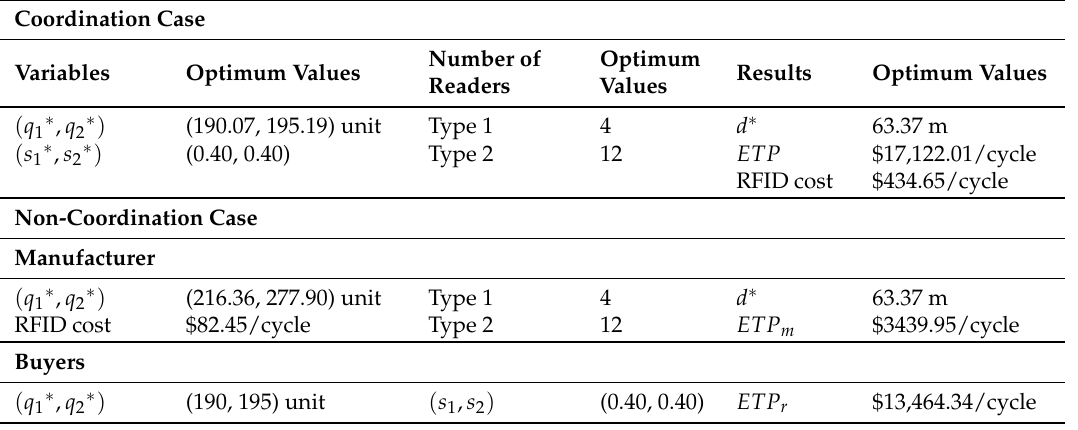
Table 6. Optimum results from the numerical analysis for Example